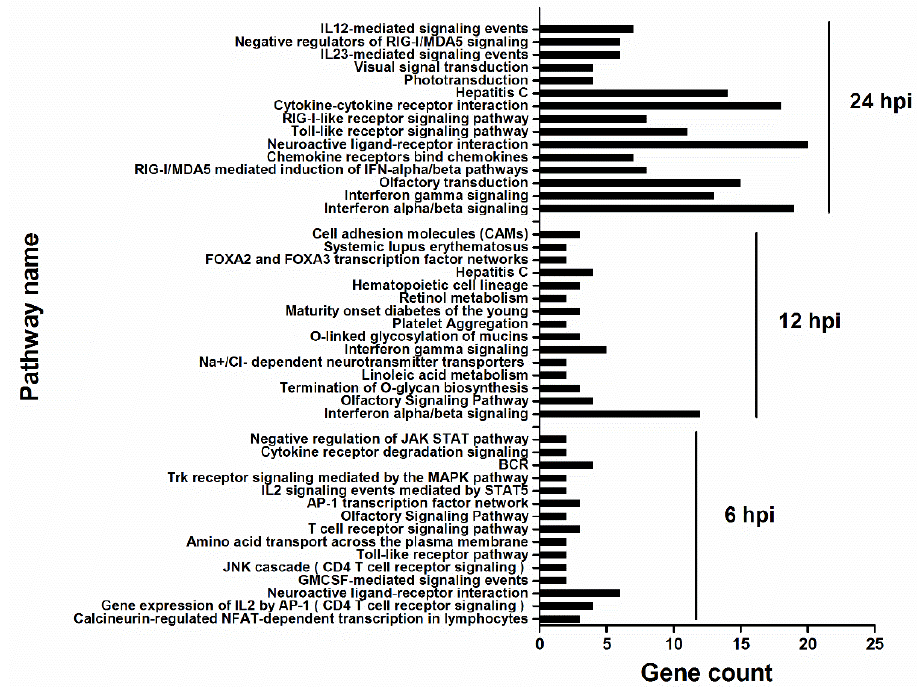
Figure 5. Significantly enriched pathways according to InnateDB. Gene count refers to DE genes in identified pathways. Many categories shared the same genes. In addition, only top 15 were showed based on the number of DE genes in